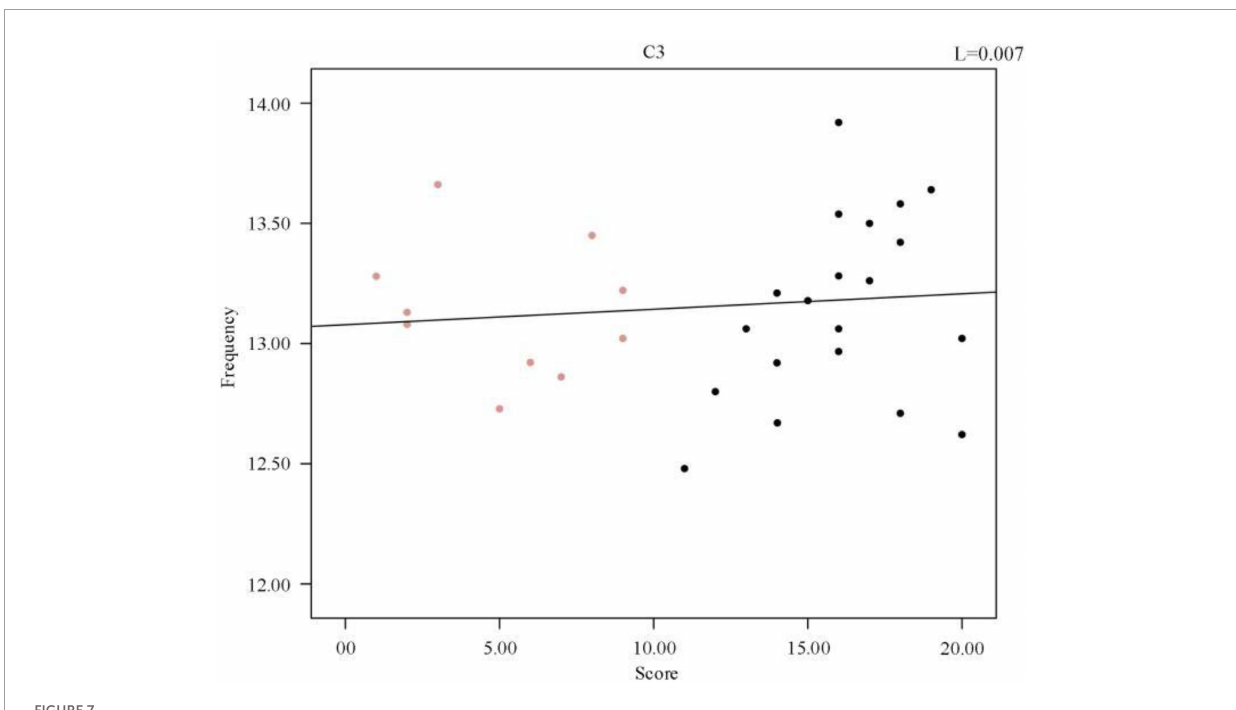
FIGURE7 Regression line of individual spindles’ mean frequency and sleep quality